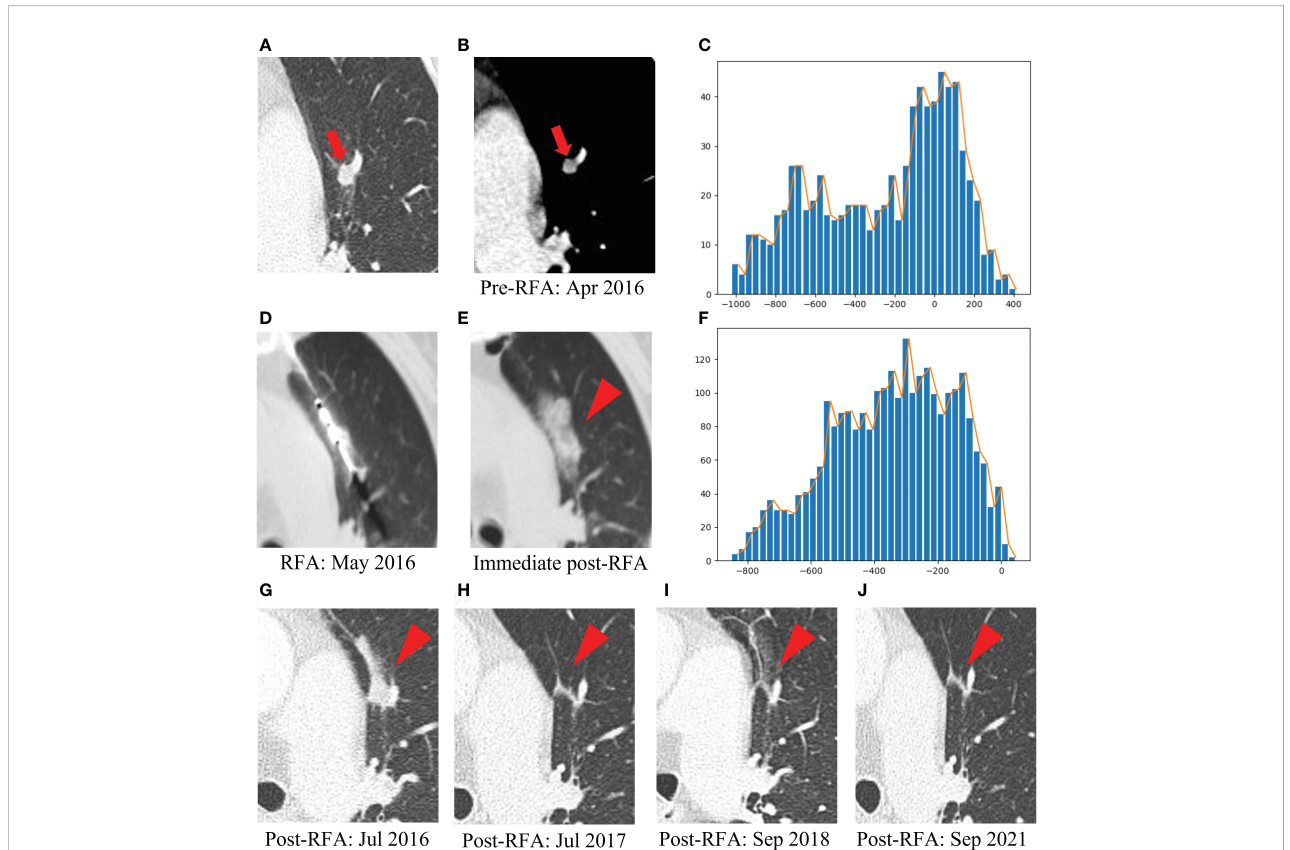
FIGURE 6 Example of a patient with post-lung RFA complete response. The multimodal data fusion model predicted the results: CR: 0.87, Non-CR: 0.13. (A) A 77- year-old female pT2N1M1R0 rectal cancer patient with a lung metastasis one year after rection, which was located in the left upper lobe (red arrow). (B) The mediastinal window of enhanced CT showed that the lesion was enhanced and adjacent to the blood vessel, with a maximum diameter of 6 mm (red arrow). (C) The histogram of the densities within this nodule on the pre-RFA CT scans displayed an asymmetric, skewed distribution corresponding to intra-tumoral enhancement (x-axis: attenuation in Houns fi eld units, y-axis: number of voxels). (D) The RFA was performed under CT guidance. (E) IAH occurred after RFA (red arrowhead). (F) The histogram of the densities within the ablation zone on the immediate post-RFA CT scans was rather fl at, without peak among the high tissular atenuations (x-axis: attenuation in Houns fi eld units, y-axis: number of voxels). (G) Chest CT scan showed high density patch shadow in the ablation area one month after RFA (red arrowhead). (H – J) One year, two years and fi ve years after RFA, chest CT scans showed that the lesion disappeared (red arrowhead). RFA, radiofrequency ablation; CR, complete response; IAH, intra-alveolar